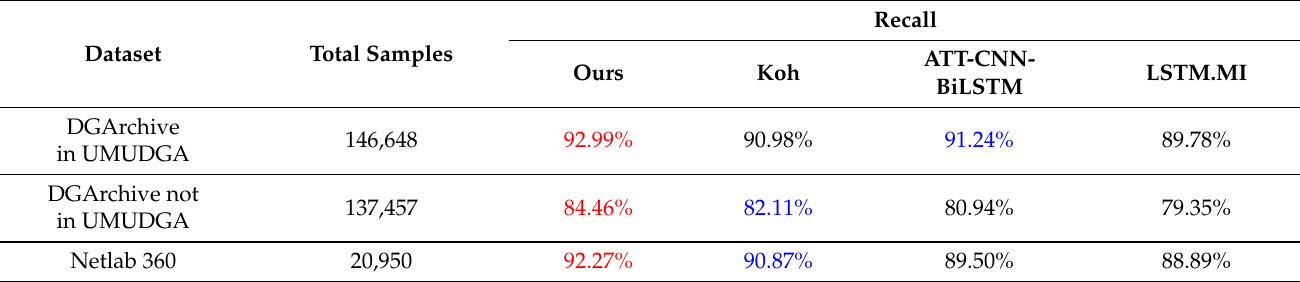
Table 5. Comparison of generalization abilities.